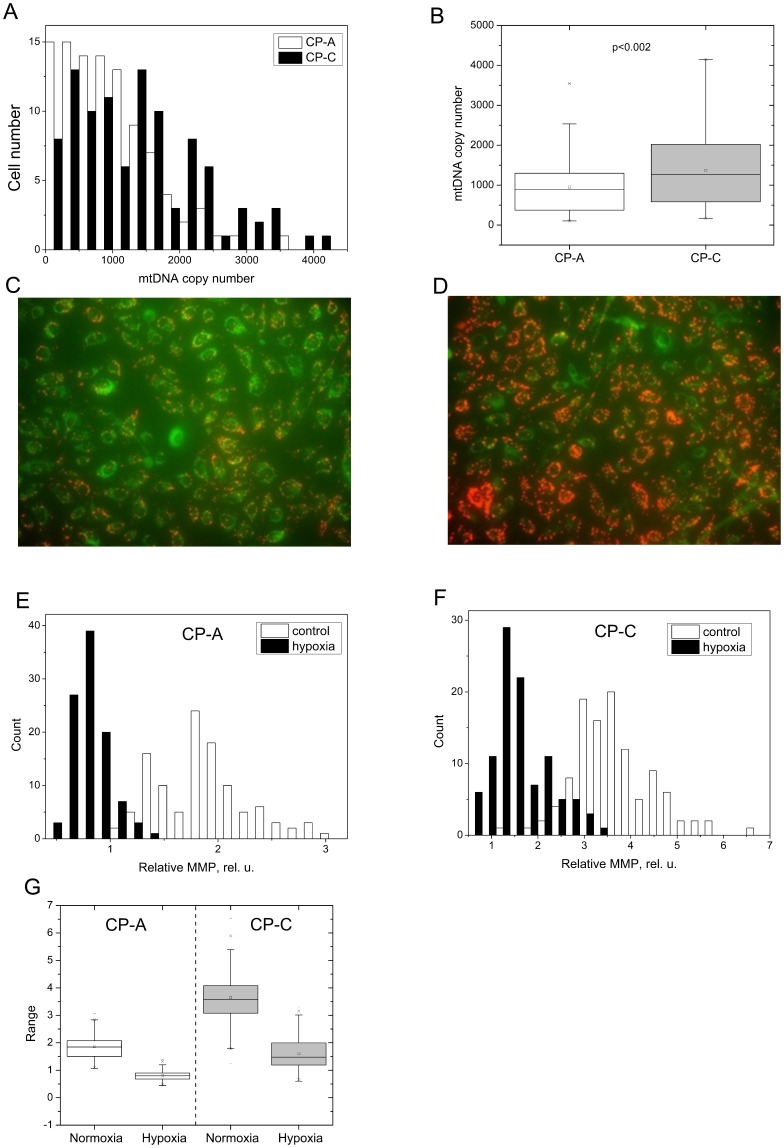
Mitochondrial DNA copy number analysis and mitochondrial transmembrane potential.A) Single cell mtDNA copy number distributions in metaplastic (CP-A) and dysplastic (CP-C) cells, B) box charts of the two distributions shown in panel A. Following values are depicted: open square – mean; solid line – median; upper and lower box lines – the 75th and 25th percentiles, respectively; upper and lower whiskers – the 95th and 5th percentiles, respectively; x – minimal and maximal values of the distribution. The p value of <0.002 was calculated using the two-tailed non-parametric Mann-Whitney statistical significance test (n = 99); mtDNA copy numbers range between 150–1,900 C–D) JC-1 fluorescence micrographs of hypoxic CP-A (C) and hypoxic CP-C (D) cells; single cell distributions of the relative mitochondrial membrane potential in CP-A (E) and CP-C (F) cells. JC-1 signals from about 100 cells per cell line and condition were analyzed; G) statistical representation of the MMP distribution in both cell types/conditions.